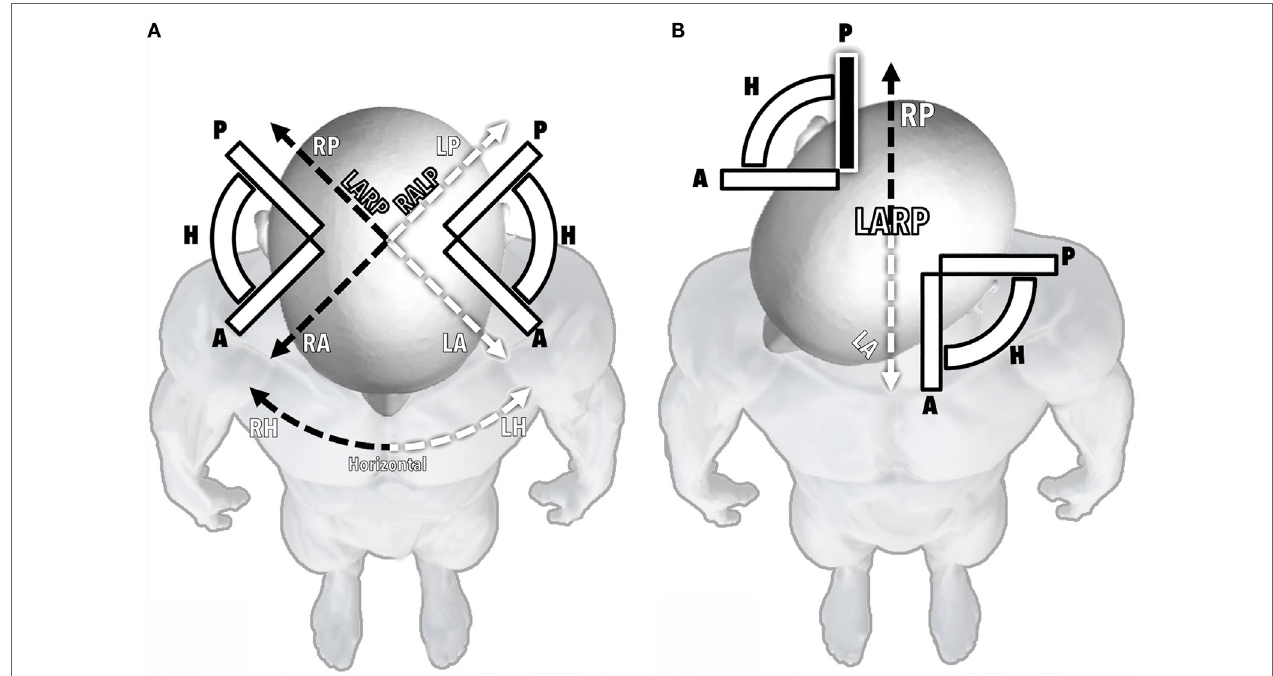
FigUre 1 | The disposition of semicircular canals . The alignment of all six canals is represented as seen from above a patient’s head. (a) Head in a neutral position. (B) Head turned 45° to the right, thus aligning the LARP plane and the left anterior and right posterior canals with the sagittal plane of the body below the neck. A, anterior canal; P, posterior canal; H, horizontal canal; RA, RP, and RH, right anterior, posterior, and horizontal canals, respectively; LA, LP, and LH, left anterior, posterior, and horizontal canals; LARP, left anterior/right posterior plane; RALP, right anterior/left posterior plane.